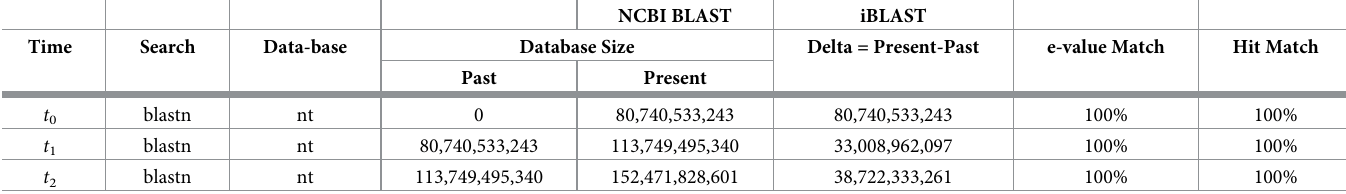
Table 2. Case study I: Fidelity of iBLAST in three consecutive time periods. blastn search was performed on nucleotide sequence databases (nt). At any time instance, the Past database size is the size of the database from the previous time instance. The Present database size is the database size at the present time instance. Delta is the incre- mental database growth from the previous time instance to the current time instance. NCBI BLAST must be performed on the entire Present database size, while iBLAST only needs to be performed on Delta